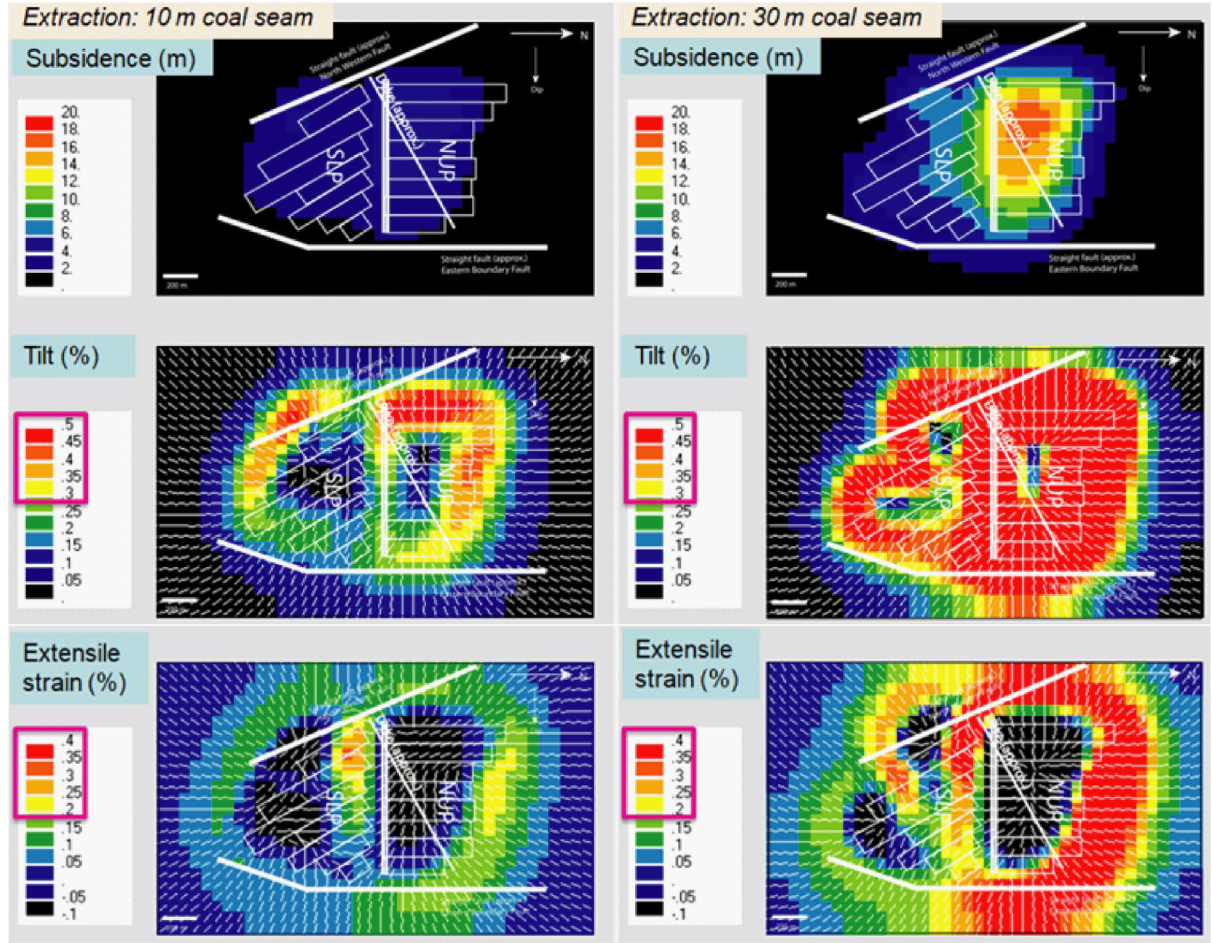
Figure 12. Future subsidence and vulnerable area considering tilt angle and extensile strain due to total extraction of 30 m coal seam. (ev ver5.01. http:// fubuki. g1. xrea. com/ rml/ fujii/ ev/ ev. htm).